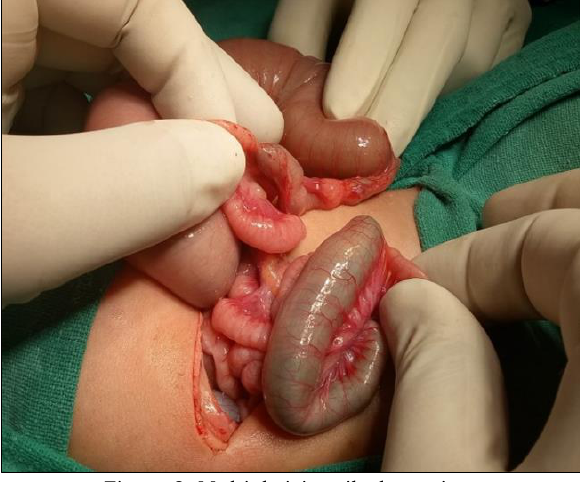
Figure 3: Multiple jejunoileal